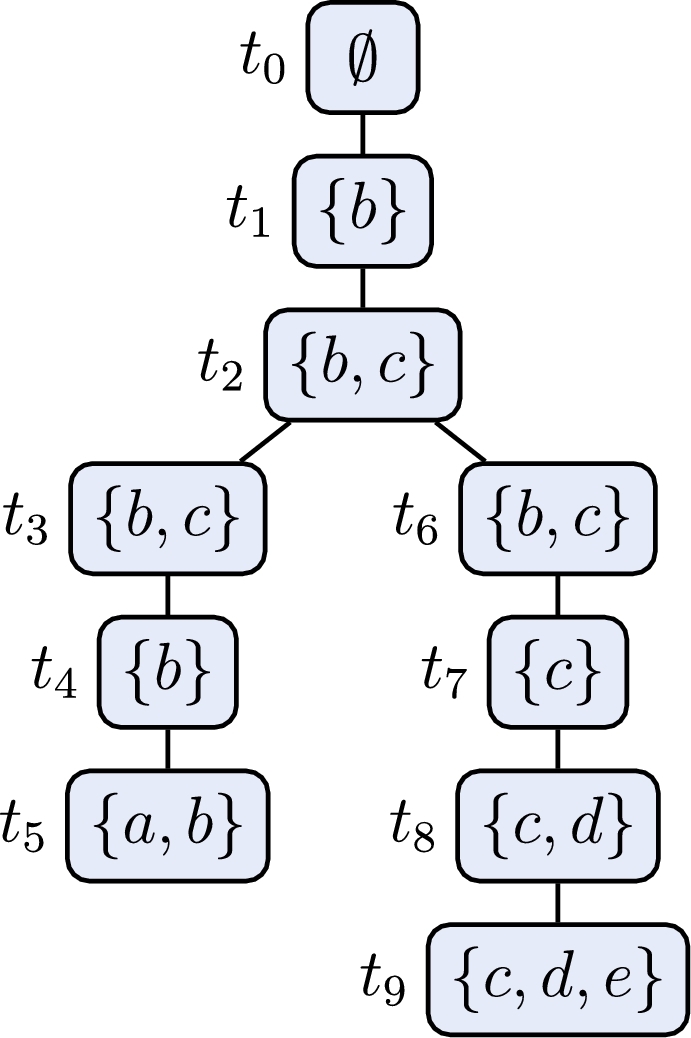
Normalized tree decomposition.